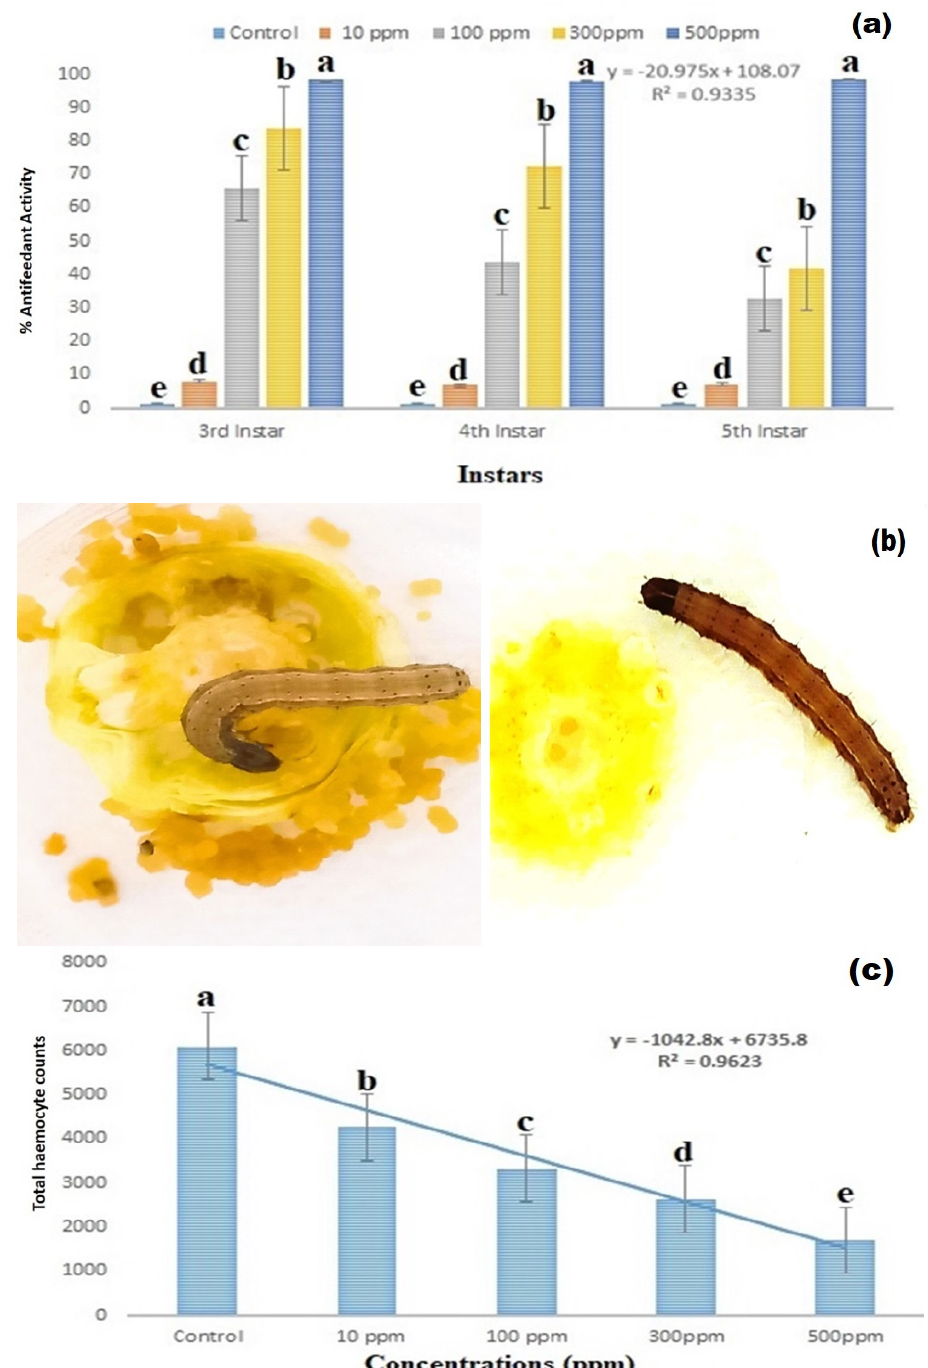
Figure 4. ( a ) CuO NPs antifeedant effect against 3rd, 4th, and 5th instar larvae of S . frugiperda after 24 h of nanoparticles treatment. ( b ) CuO NPs antifeedant effect against 3rd, 4th, and 5th instar larvae of S . frugiperda after 24 h of nanoparticles treatment . Control ( without nanoparticles ) and copper nanoparticles treatment. ( c ) Insect larval hemocyte count after copper nanoparticles treatment against 3rd instar larvae of S . frugiperda . According to the Tukey test at p ≤ 0.05, statistical